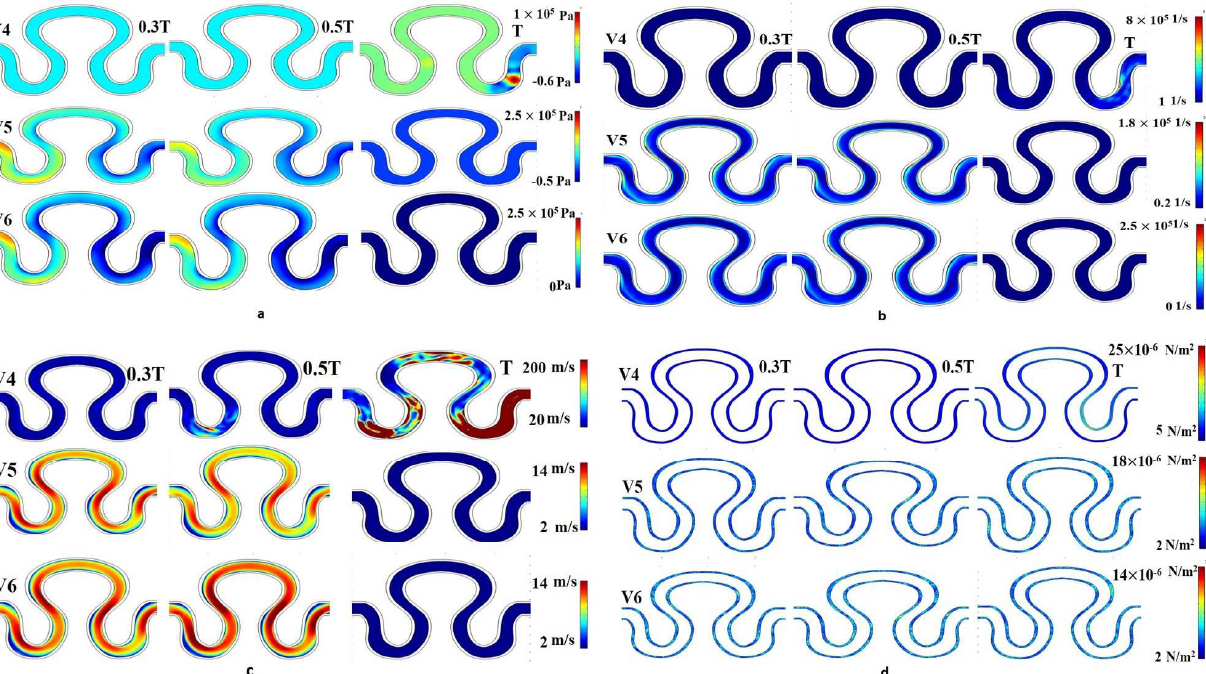
Figure 9. Contour Plot of ( a ) pressure, ( b ) shear rate, ( c ) axial velocity, ( d ) wall stress for physiological flow, slip wall boundary condition for velocity models V 4 , V 5 and V 6.